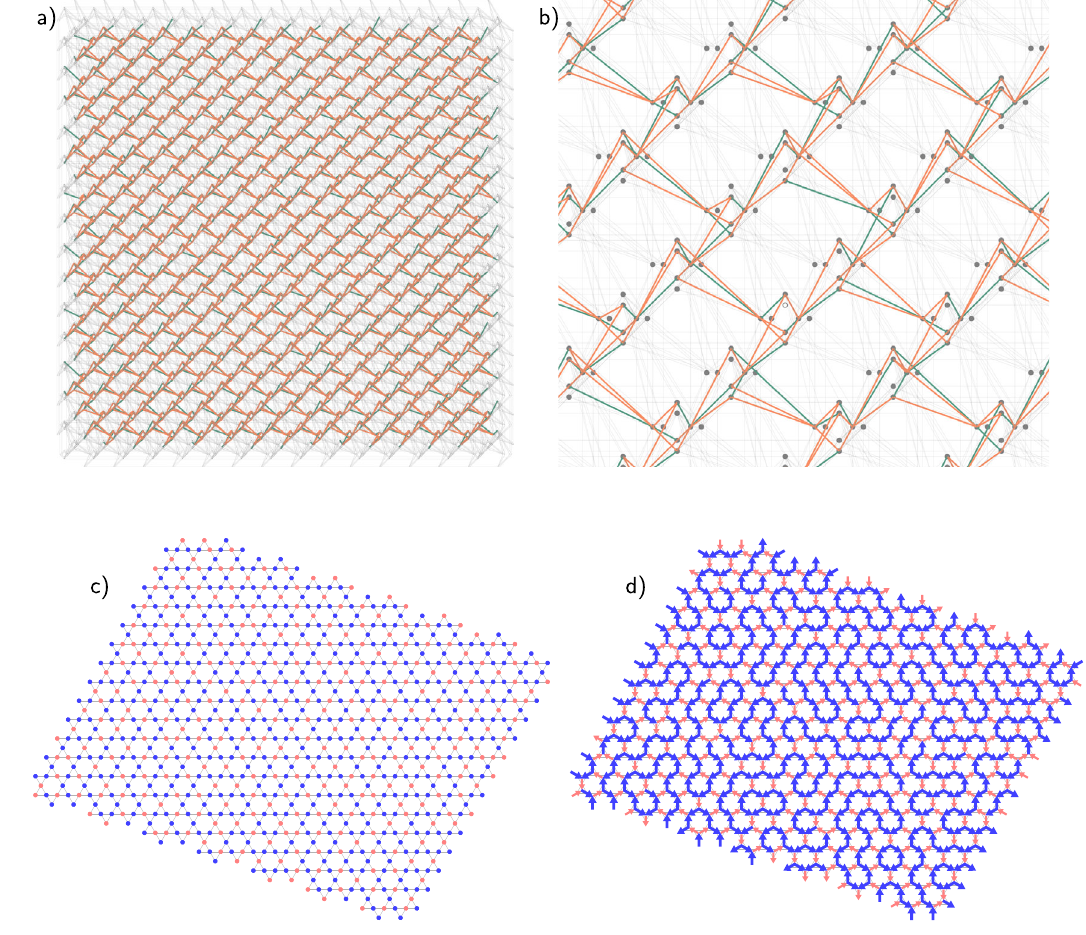
Fig. 6 | Embedding of the kagome lattice into the qubit graph. a and b Each kagomesiteisrepresentedbythreequbits,coupledtogetherferromagneticallyina chain ( J ij = − 1.5). The entire qubit graph and embedding are shown in a with green and orange lines representing FM and AFM couplers, respectively; b shows a